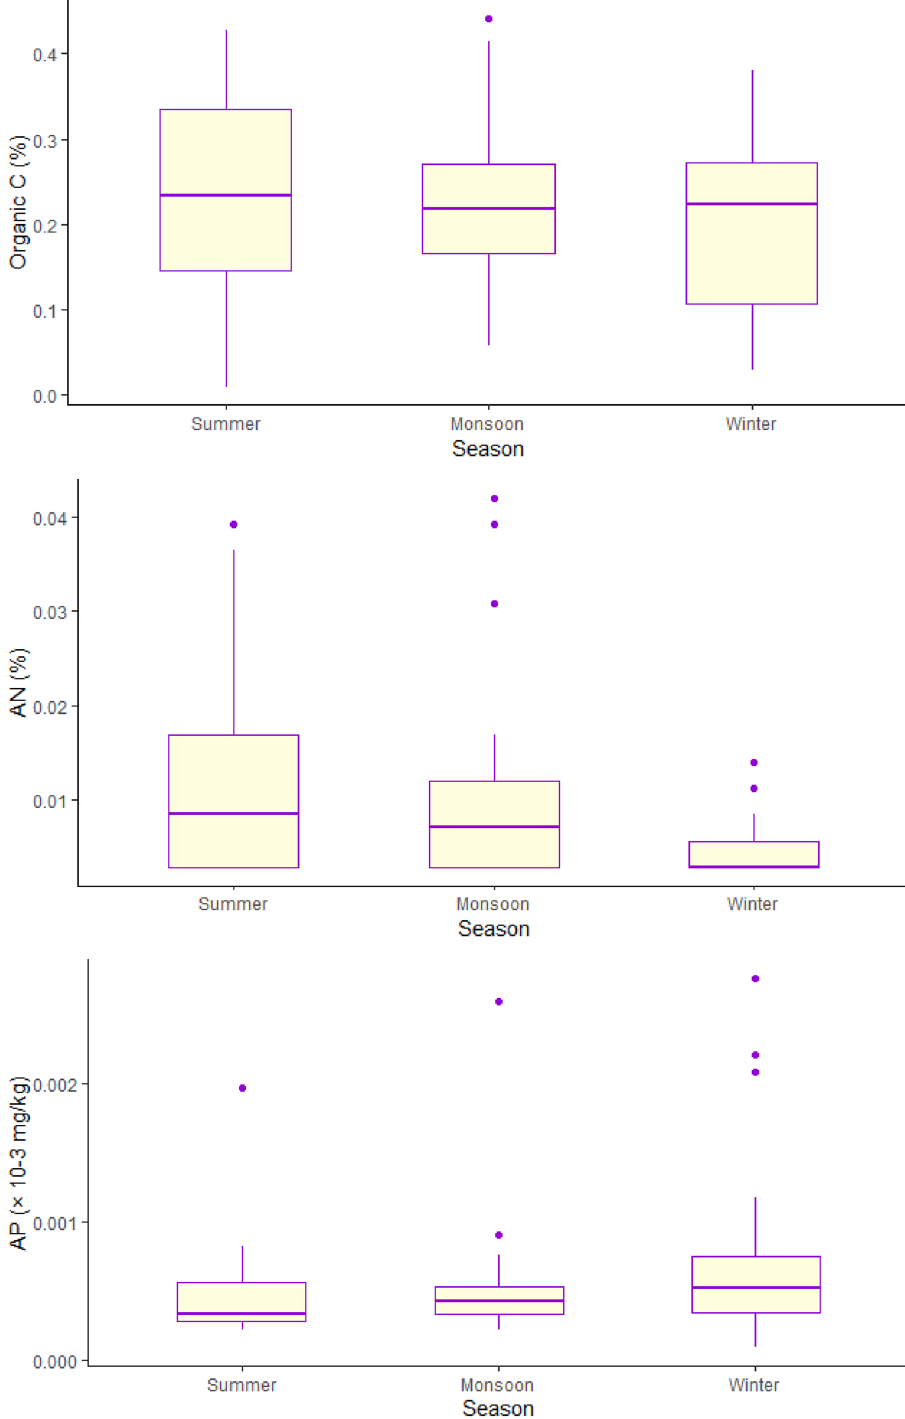
Figure 4. Soil carbon, available nitrogen, and phosphorus levels for the year 2015 for